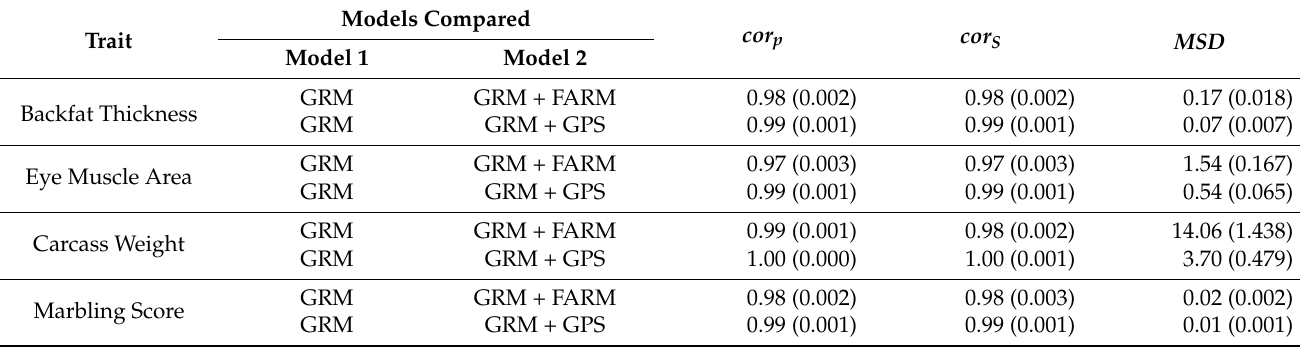
Table 5. Comparisons of the predicted genomic breeding values (PGBV) between the model that modelled the PGBV alone (GRM) and the models that accounted for the herd effects, either as independent (GRM + FARM), or as correlated (GRM + GPS), for all four traits and all the five models evaluated. The comparisons were performed based on the Pearson ( cor P ) and Spearman ( cor S ) correlations between the PGBVs, and on the mean squared differences between the PGBVs n test (cid:0) (cid:1) 2 ∑ ( MSD model 1, model 2 = 1/ n test ). Values in this table are the mean and standard deviations (in (cid:101) g i , model 1 − (cid:101) g i , model 2 i = 1 parenthesis) of the comparisons over 100 cross-validation replicates of each